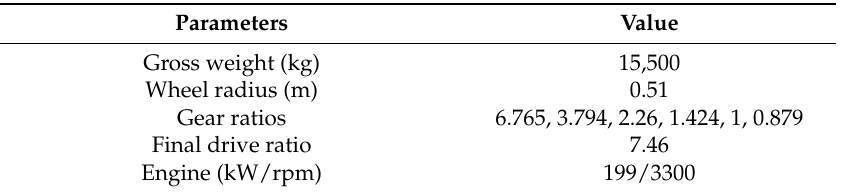
Table 2. Key parameters of the target vehicle